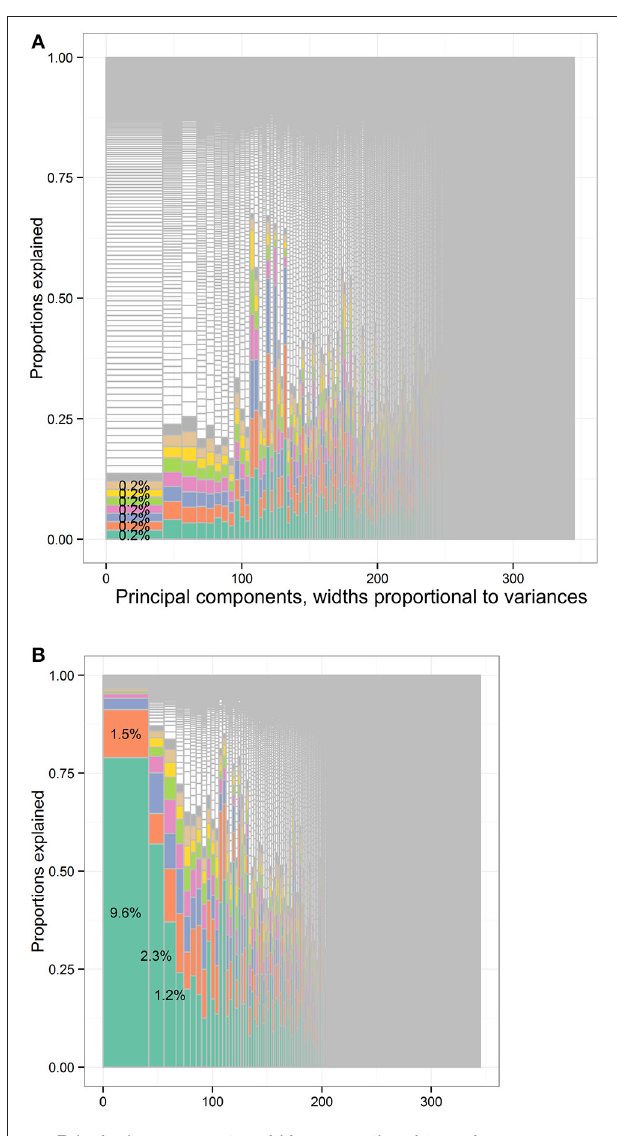
FIGURE 10 | The distribution of total variances by principal components and input variables or approximation variables in the Canadian Health Measures Survey cycle 1–3 data set. Principal components, widths proportional to variances. (A) The distribution of variances of the full data set of the CHMS cycle 1 to 3 according to the PCA loadings. There were 345 columns separated by solid vertical gray lines. Principal components, widths proportional to variances. (B) The distribution of variances of the full data set of the CHMS cycle 1–3 according to the forward regression. There were 345 columns separated by solid vertical gray lines. CHMS, Canadian Health Measures Survey; PCA, principal component analysis. Each column represented the principal components (PCs) and had widths the same as the PC variance. In each column, the cells were of unequal sizes representing the variances contributed by the input variables. The cells in each column represented the input variables. The cell sizes were proportional to the variances that the input variables contributed to PCs. The cells were ordered by the variances contributed by input variables or cell sizes. The variable names were not specified in the graph for limited spaces. The eight leading (Continued)